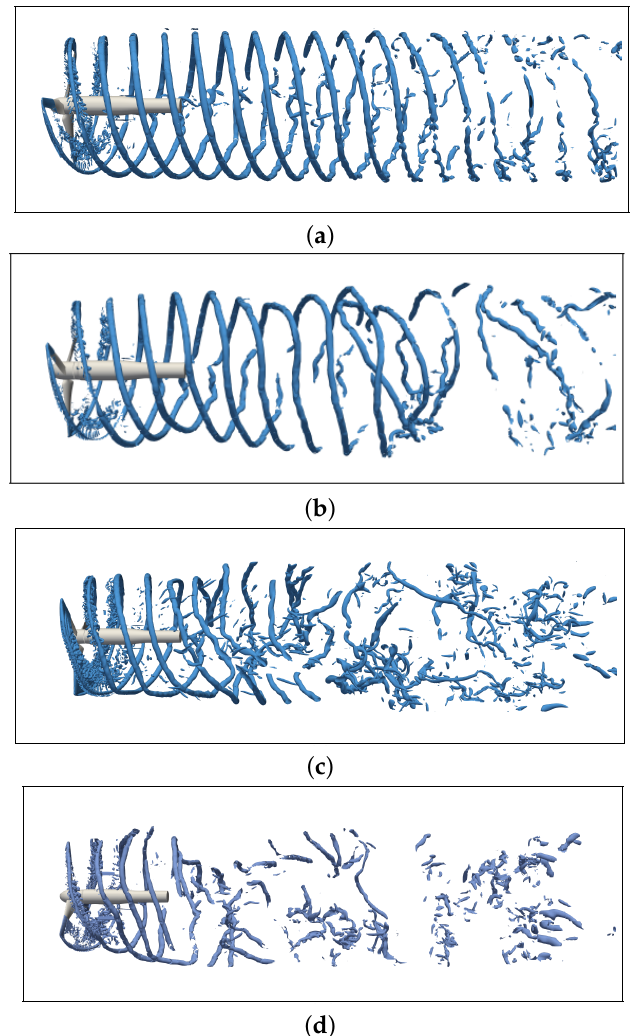
Figure 25. Iso-surface of λ 2 criterion showing tip-vortices of tidal turbine simulated in LBM-LES at TSR = 3.67 with upstream turbulence intensities of I = [ 0,3,8,12.5 ] %. ( a ) I = 0%. ( b ) I = 3%. ( c ) I = 8%. ( d ) I =